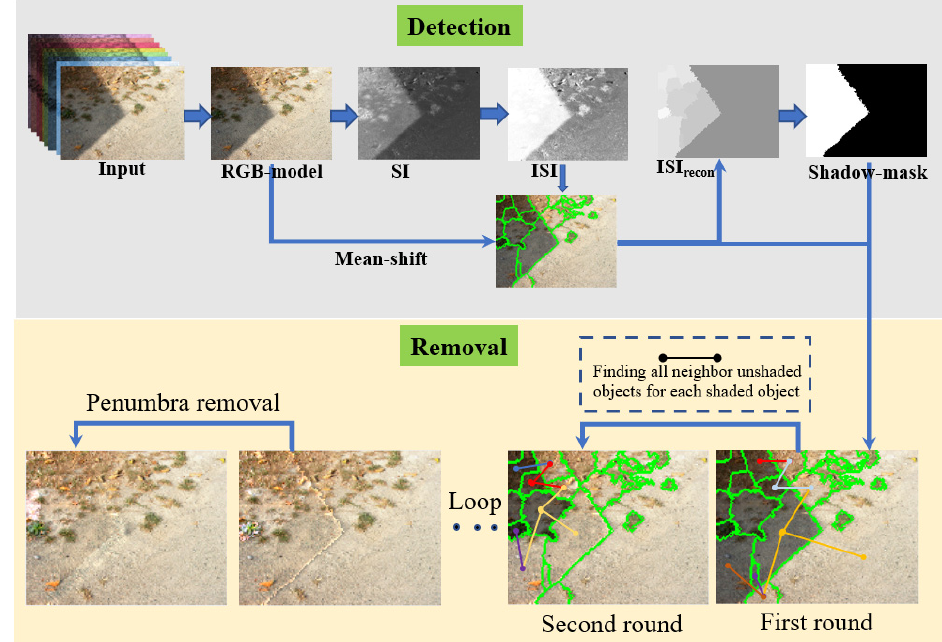
Figure 1. Flowchart of the proposed methods.